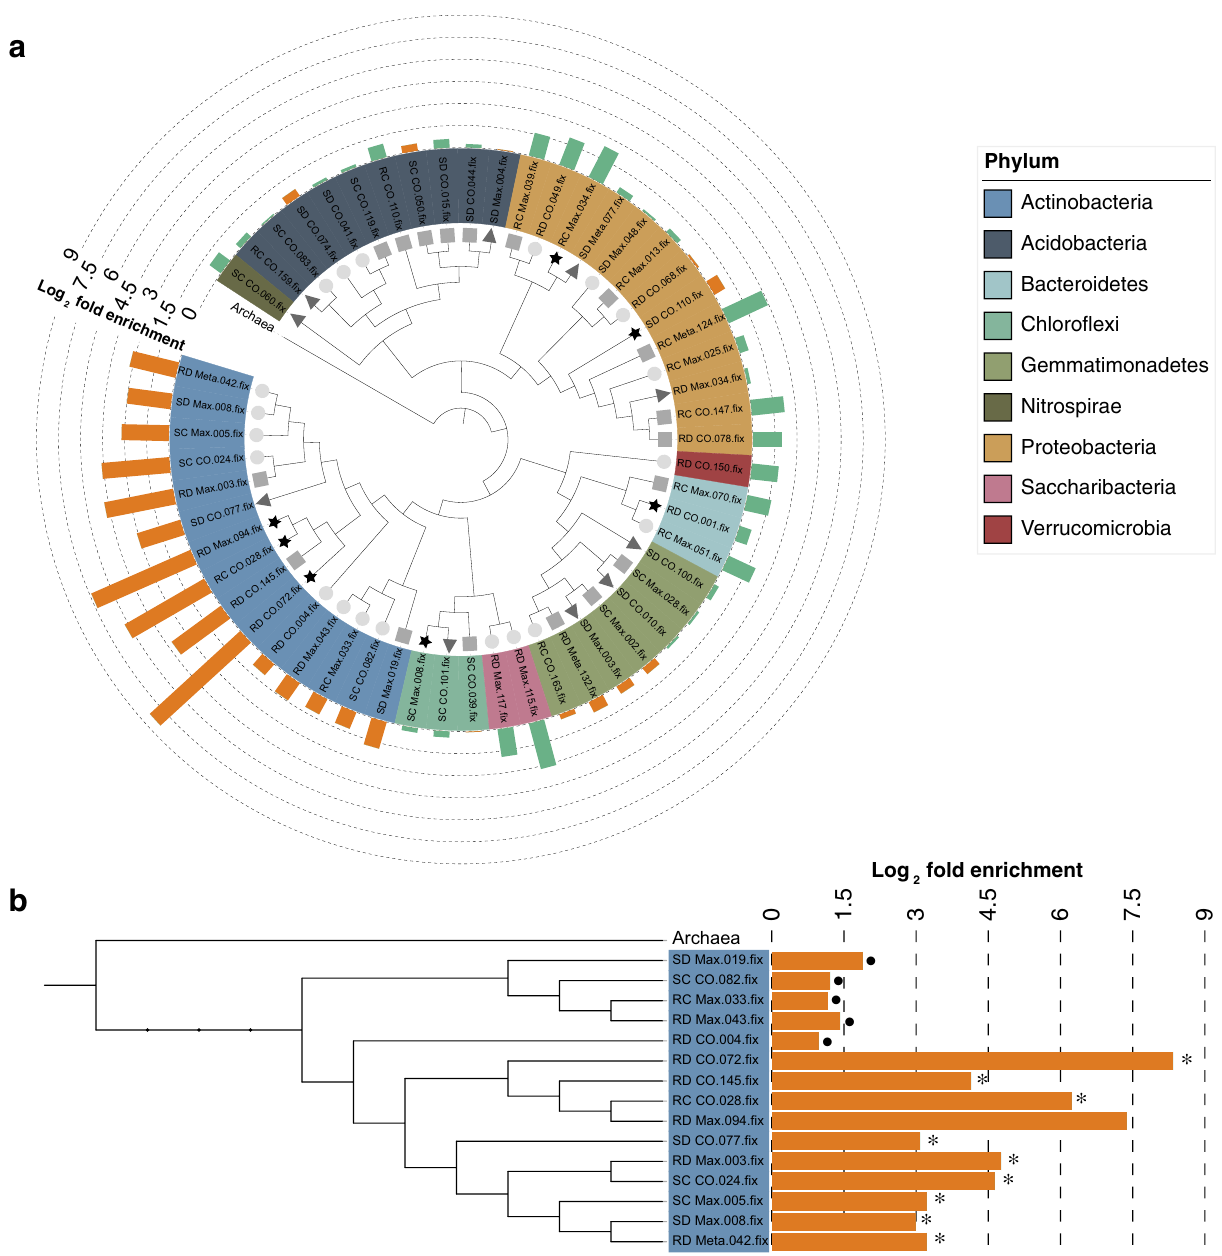
Fig. 3 Phylogenetic tree of the 55 MAGs. a The phylogenetic tree at the center of the fi gure was constructed from all 55 MAGs. Symbols located at the end of tree branches (inner ring) represent the estimated genome completeness of each MAG. Stars (black) indicate completeness greater than 90%; triangles (dark gray) represent completeness between 80 and 89.9%; squares (medium gray) indicate completeness between 70 and 79.9%; circles (light gray) indicate completeness between 60 and 69.9%. The colored middle ring represents the phylum each MAG belongs to. The outer ring of colored bars represents the relative log 2 fold enrichment (orange) or depletion (green) of each MAG within drought-treated rhizosphere compared with watered control rhizosphere. The tree was re-rooted using an Archaeal outgroup clade. b Phylogenetic tree of 15 Actinobacterial MAGs pruned from the tree of 55 MAGs in ( a ). The label on the left represents the name of each MAG in the dataset. The bar plot at the right indicates the log 2 fold enrichment under drought in the rhizosphere community. Dots to the right of a bar indicate non-signi fi cantly enriched MAGs, p -value > 0.05; asterisks to the right of the bar indicate signi fi cantly enriched MAGs, p -value < 0.05. The log 2 fold enrichment and p values were calculated using